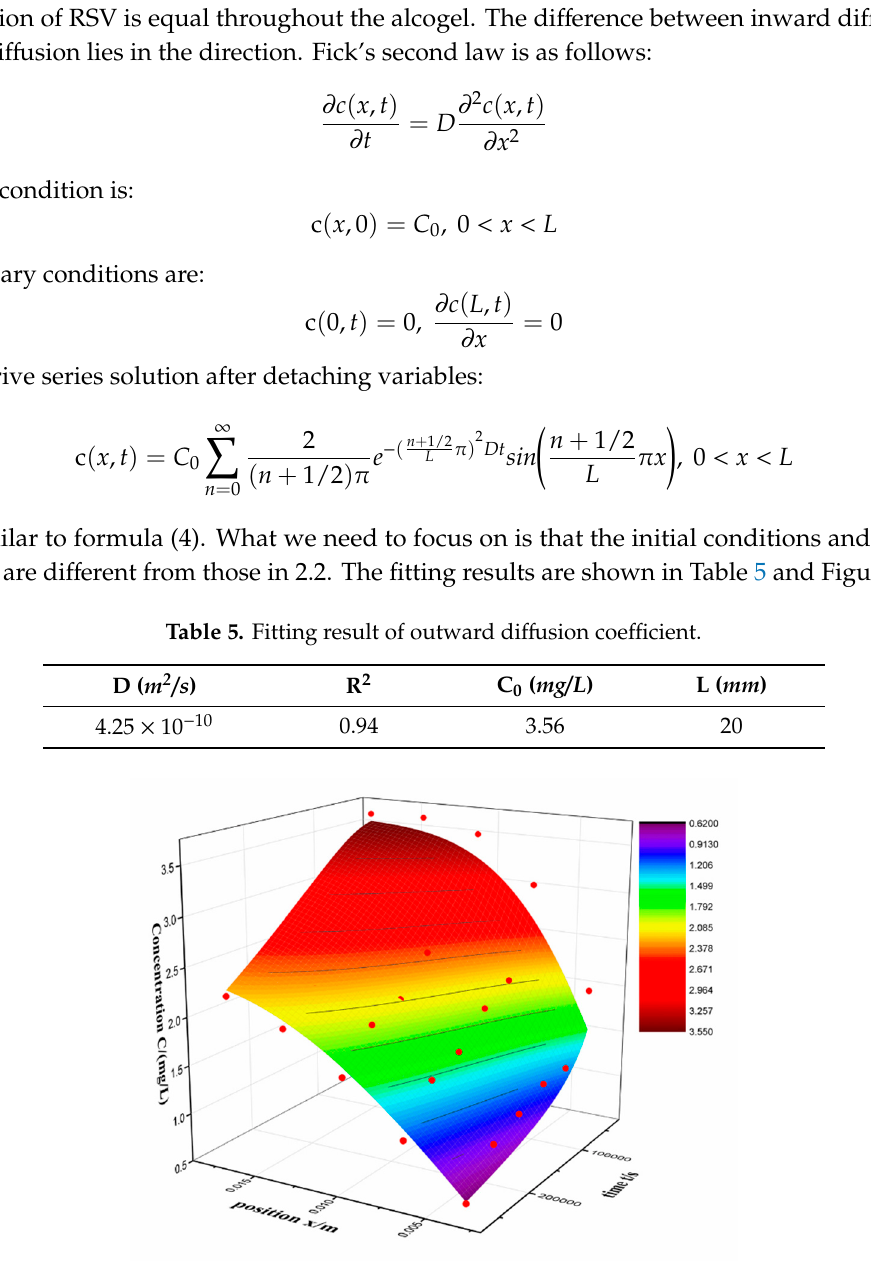
Figure 6. Original experimental data and fitted surface of outward diffusion.